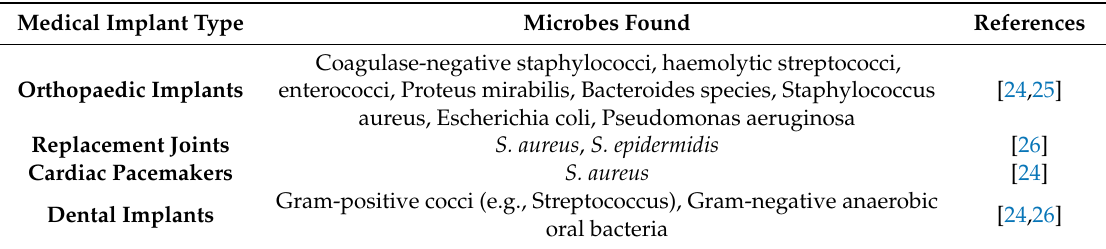
Table 1. Summary of biofilm-forming microorganisms commonly found on titanium medical